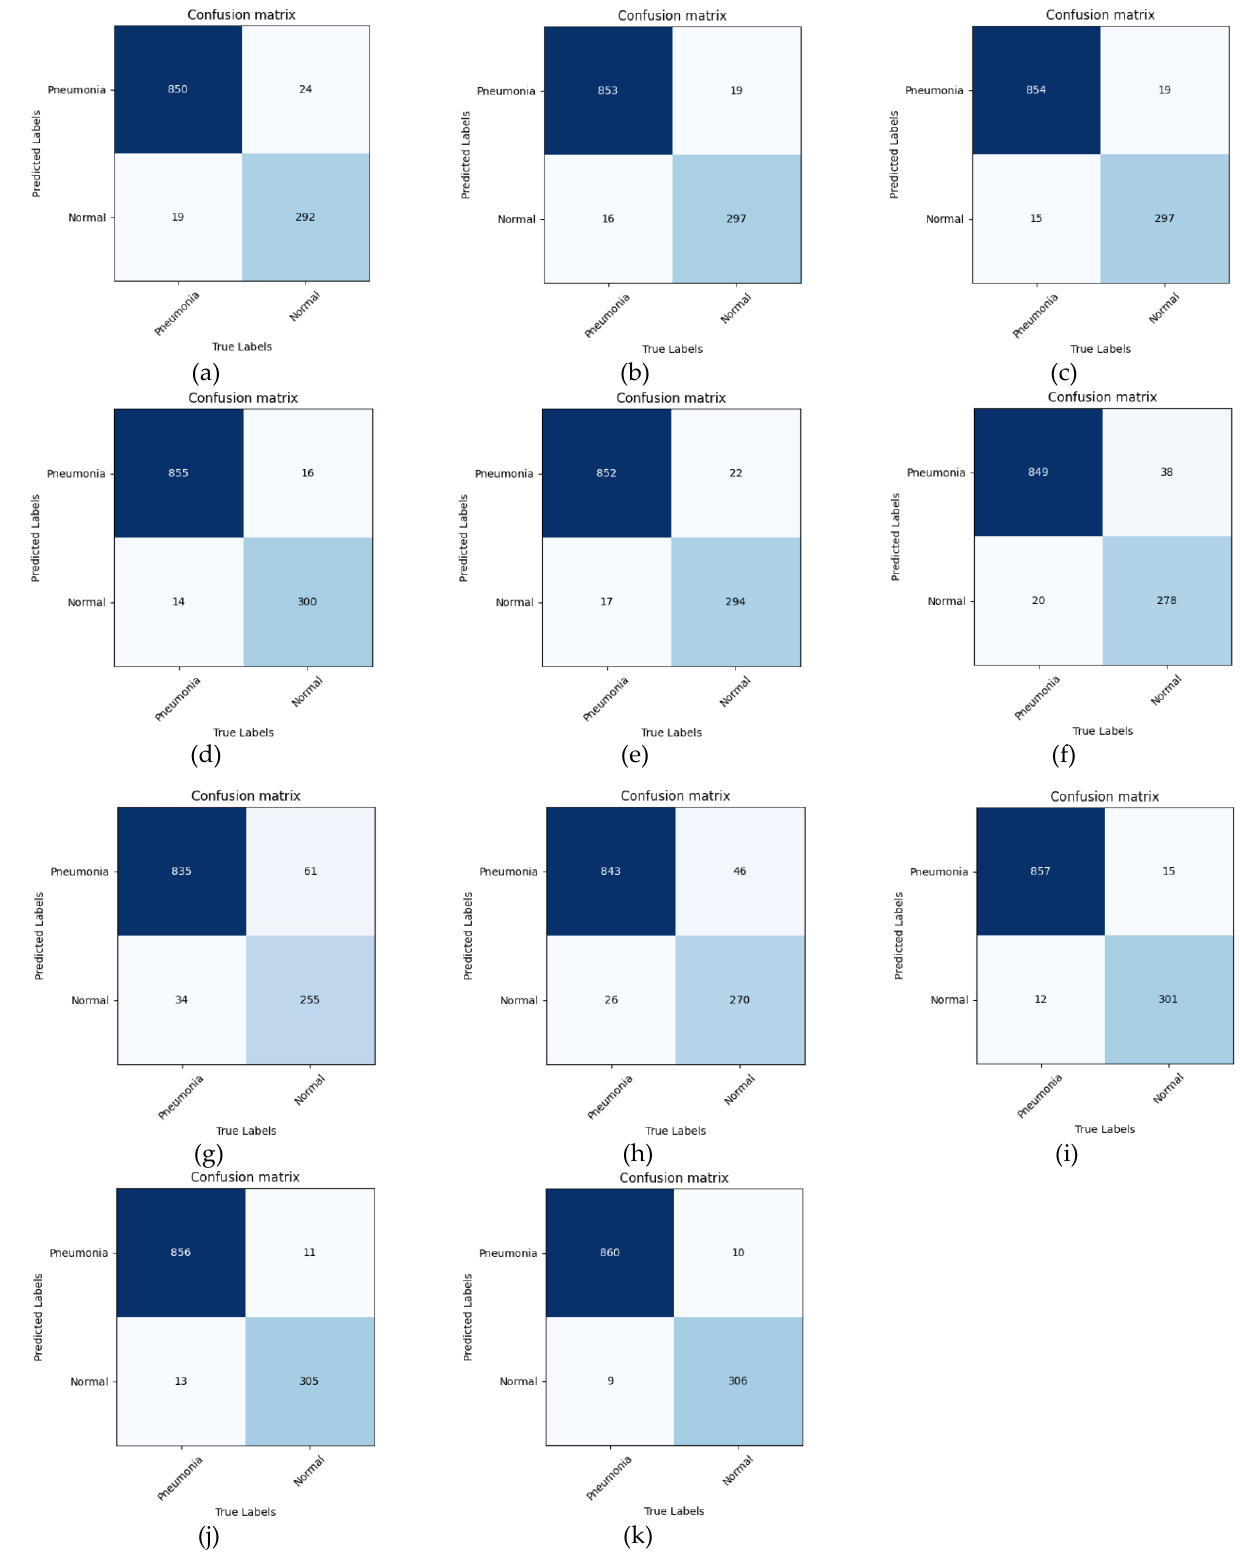
(k) Figure 4. The confusion matrix on the test set of the COVID-19 Radiography database. (a) VGG16; (b) ResNet50; (c) DenseNet121; (d) [41]; (e) [42]; (f) [43]; (g) ViT; (h) Swin Transformer; (i) Uni- former; (g) AlterNet; (k) BoT-ViTNet.